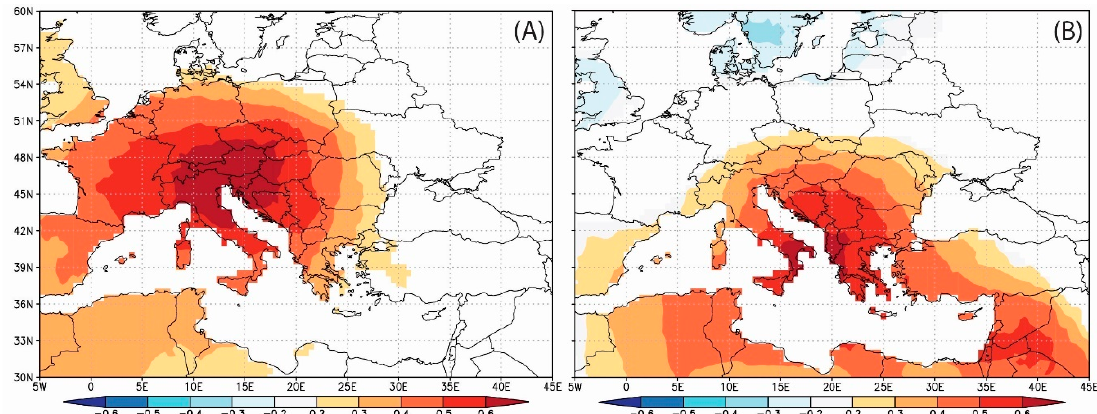
Figure 9. Spatial field correlation ( p < 0.05) between ( A ) CRU TS dataset summer temperature (JA) and δ 13 C chronology of Larix decidua from the Alps for the period 1907–2006 [24] and ( B ) CRU TS dataset summer temperature (JA) and δ 13 C Pinus chronology from Montenegro for the period